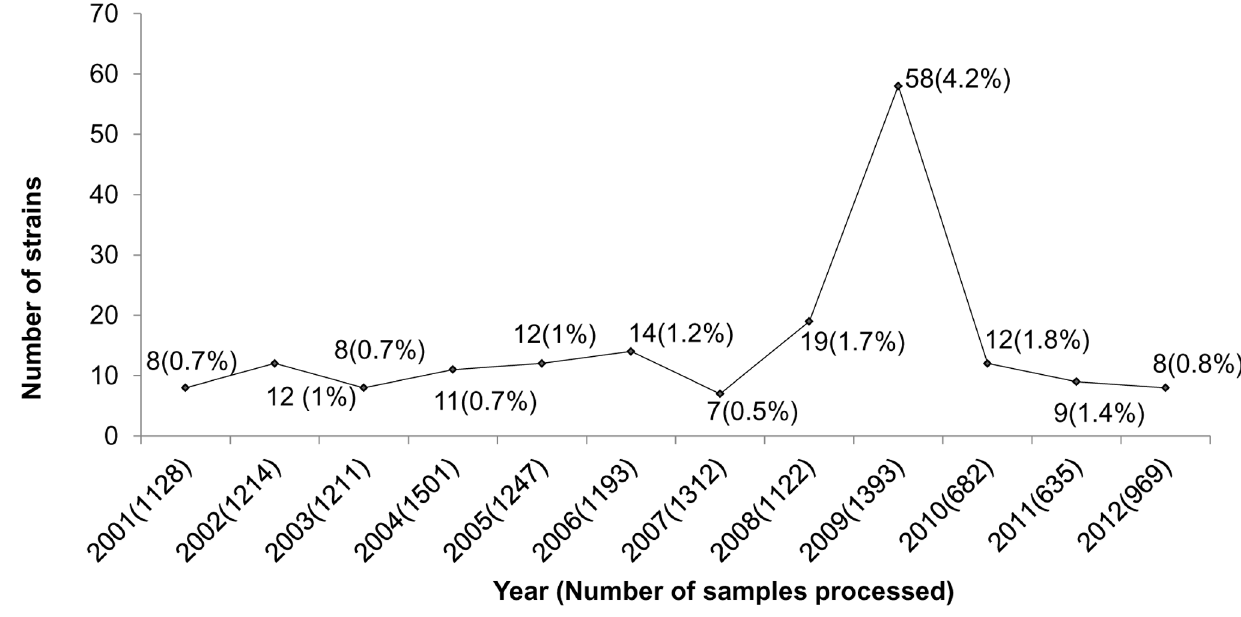
Figure 1. Isolation rate (%) of V.parahaemolyticus among hospitalized diarrheal patients in Kolkata.